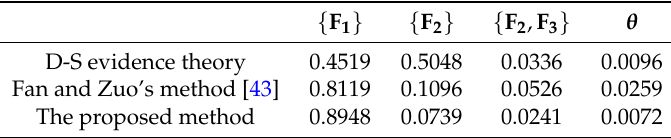
Table 2. Comparison between the proposed method and other methods. D-S,